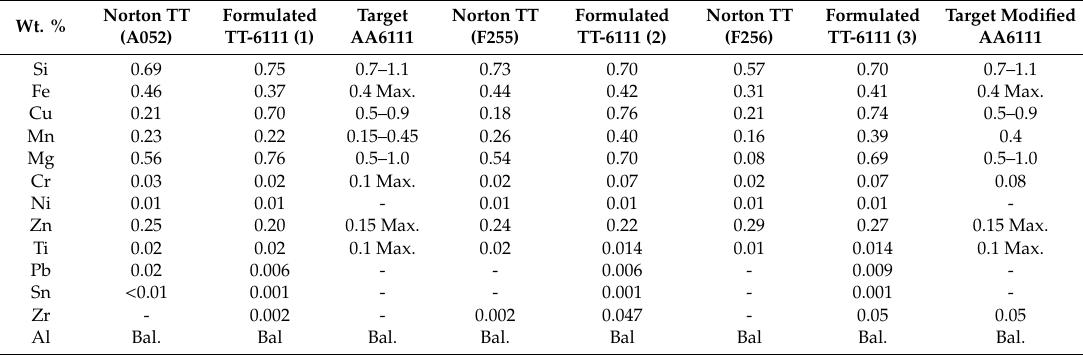
Table 1. Compositions of as-received TT ingots, formulated TT-6111 and target AA6111 alloys. Wt.